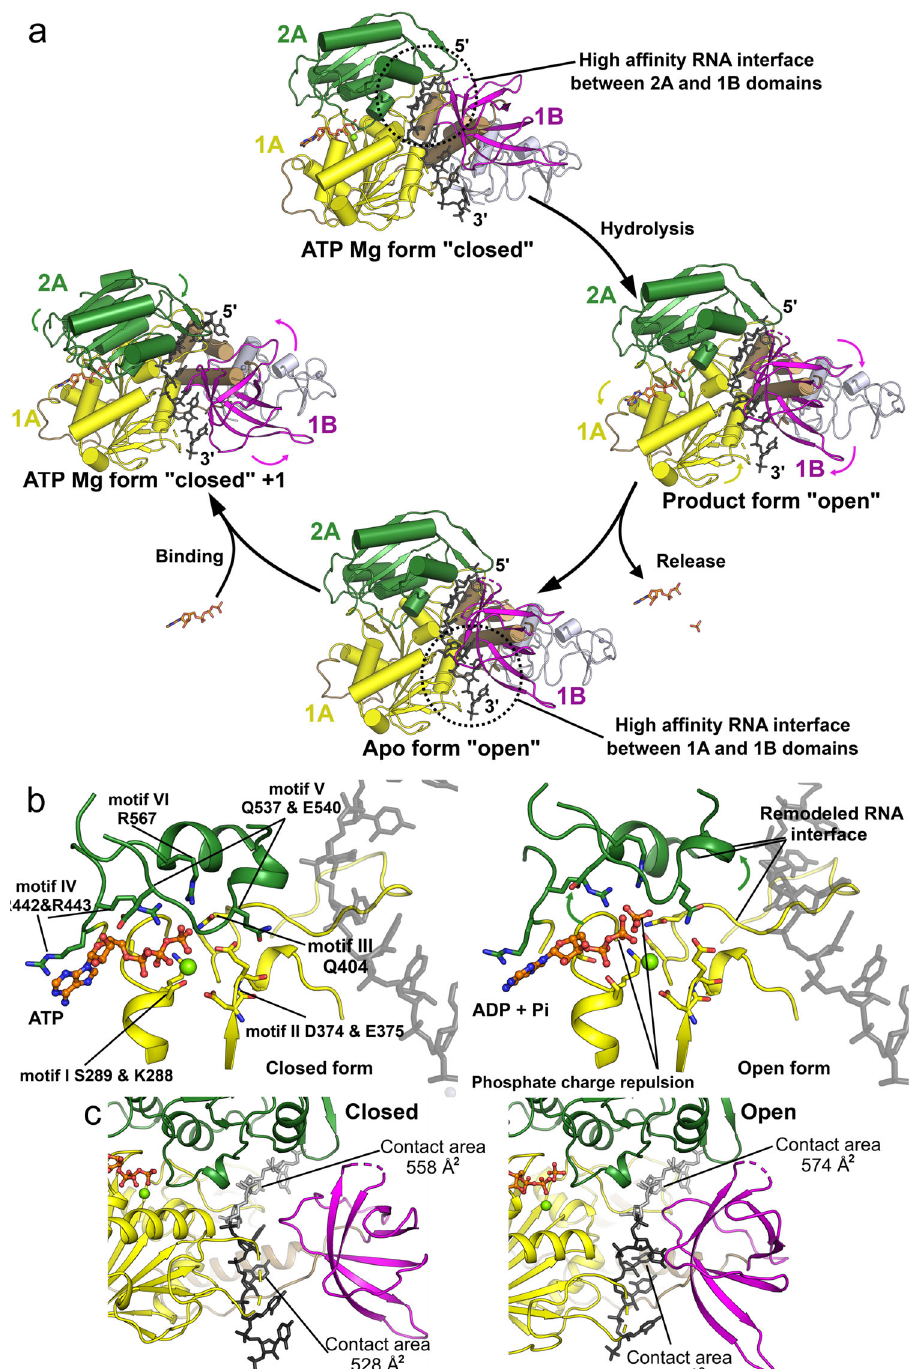
Fig. 3 Model for the NSP13 5 ′ to 3 ′ translocation mechanism. a Proposed translocation mechanism for NSP13 based on the transition from the closed (pre hydrolysis) to open (Product and APO) forms. The transitions are initiated by the binding, hydrolysis and release of ATP which triggers the conformational changes and remodels the RNA interface. b Close up view of the active site with ATP in the closed conformation (left) and ADP and Pi in the open conformation (right). Hydrolysis as subsequent charge repulsion could trigger the opening of the cleft between the two domains with conserved motifs on the 2A domain primarily contacting the product phosphate whilst the ADP product interacts with the 1A domain. Several of the phosphate interacting motifs are proximal to regions of the RNA binding interface indicating the possibility of modulation based on hydrolysis status. c Remodeling of the RNA interface based on the position adopted by the 1B domain. The closed conformation shows on the left and the open on the right. The contact areas for the 5 ′ and 3 ′ RNA regions (depicted in gray and black) is